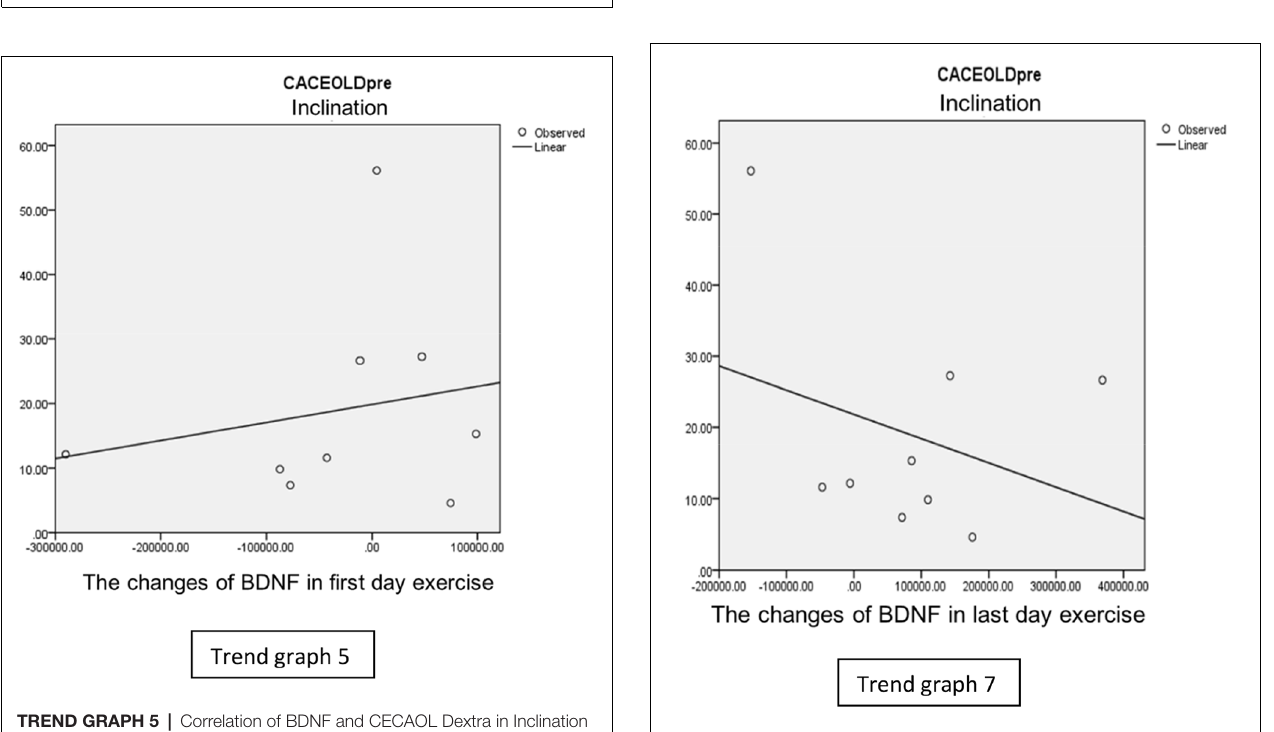
correlation between BDNF and CECAOLS. Low value of BDNF led to small changes of CECAOLS of the right